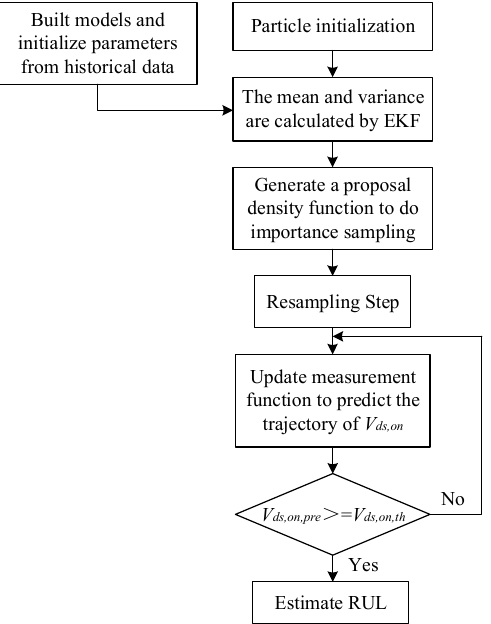
Figure 9. An EPF-based RUL estimation algorithm flow.